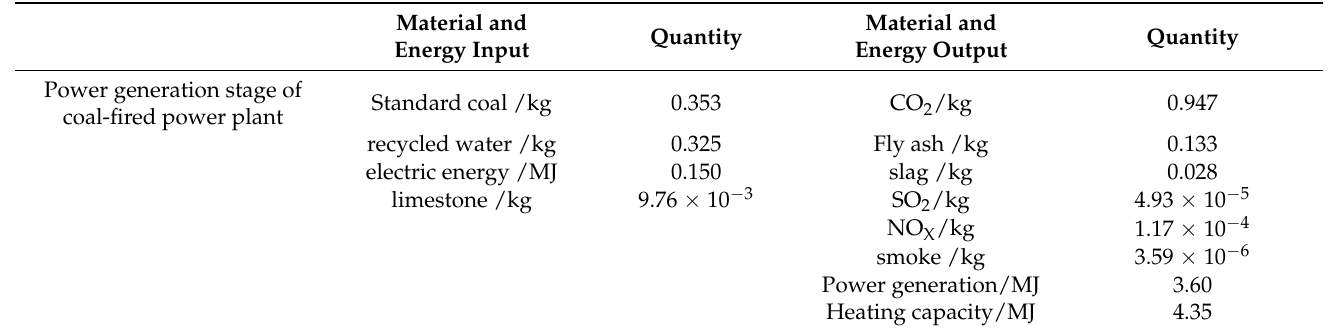
Table 1. Input and output of materials and energy required for coal-fired power plants to generate 1 kwh.